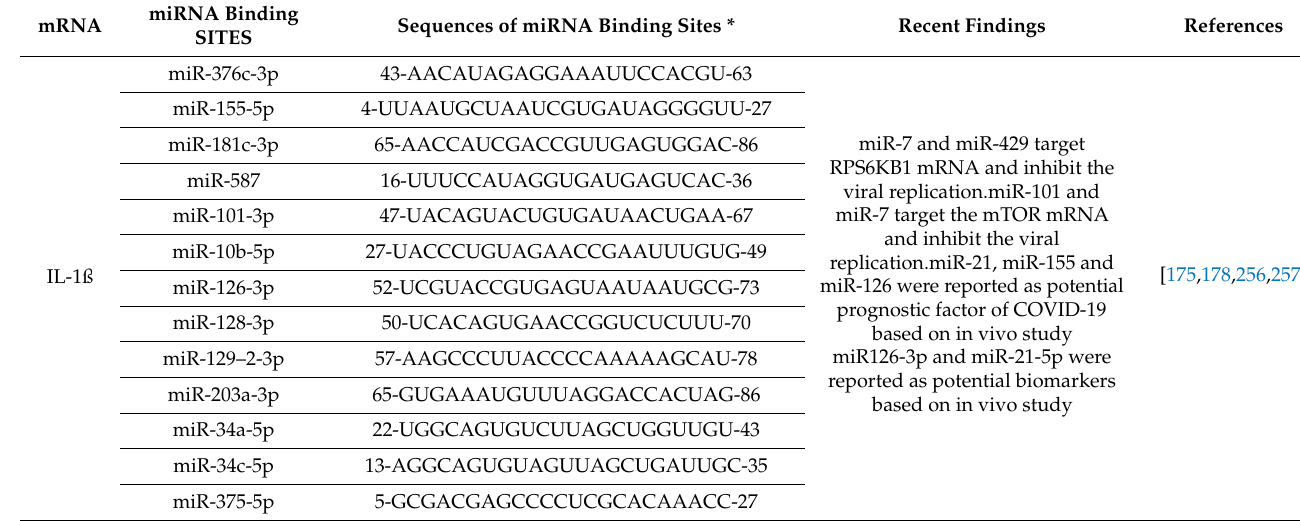
Table 2. List of miRNAs that target the 3 (cid:48) UTRs of IL-1 β , IL-6, and IL-8 mRNAs, and the recent findings amid the COVID-19